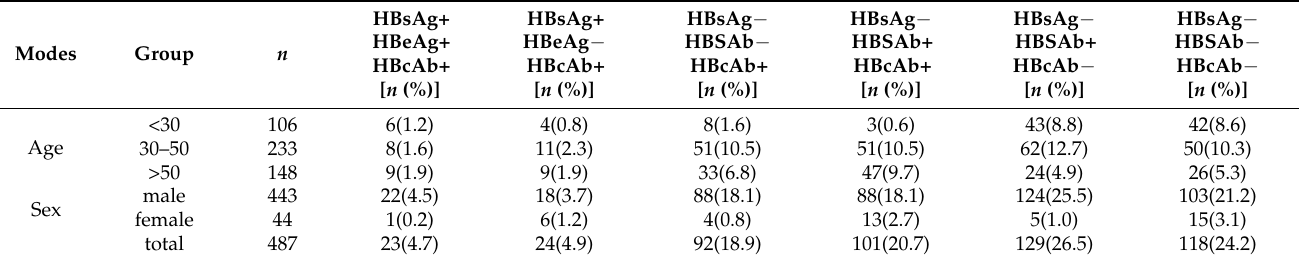
Table 1. The distribution of different modes of HBV serological markers among HIV-positive inpatients.